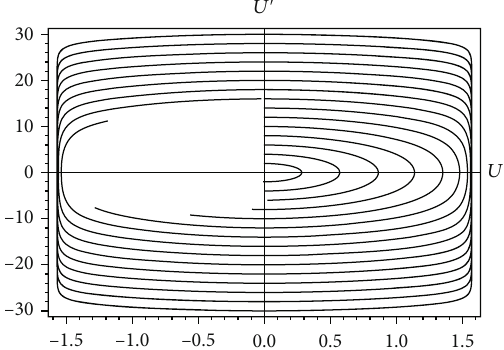
0.0 Figure 22: Solutions of the Cauchy problems (41), u ð 0 Þ = 0 , u ′ ð 0 Þ = i , and i = 2, 4, ⋯ , 15 on the interval ð 0, π /7 Þ